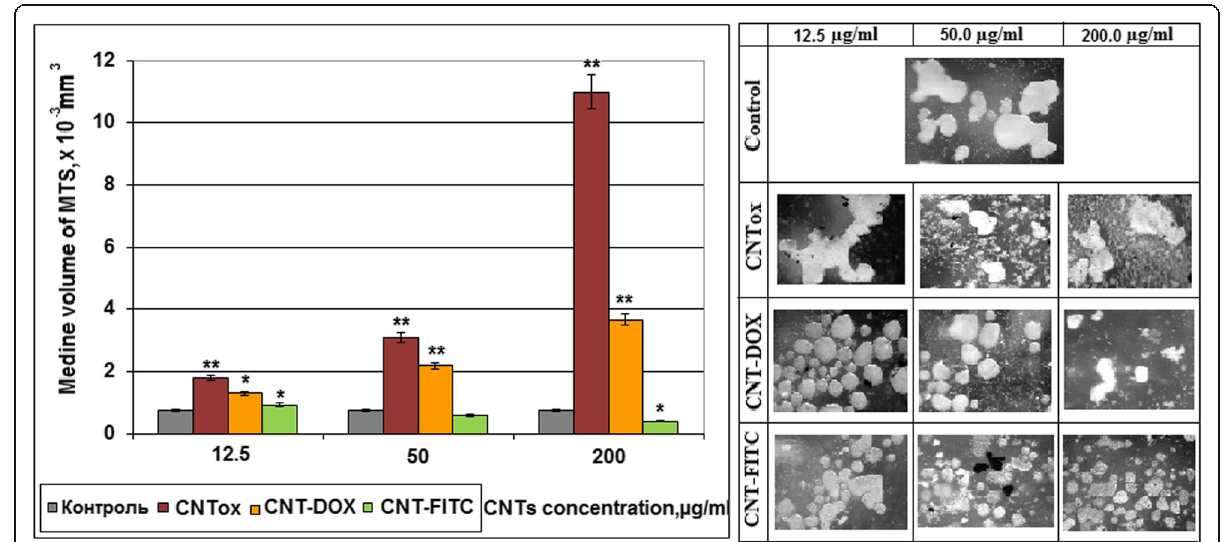
Fig. 7 The median of multicellular tumor spheroids volume. MTS were generated in presence of CNTox (sample #1), CNT-Dox (sample #3), CNT- FITC (sample #5). Statistical significance: * р ≤ 0.05 or ** р ≤ 0.01